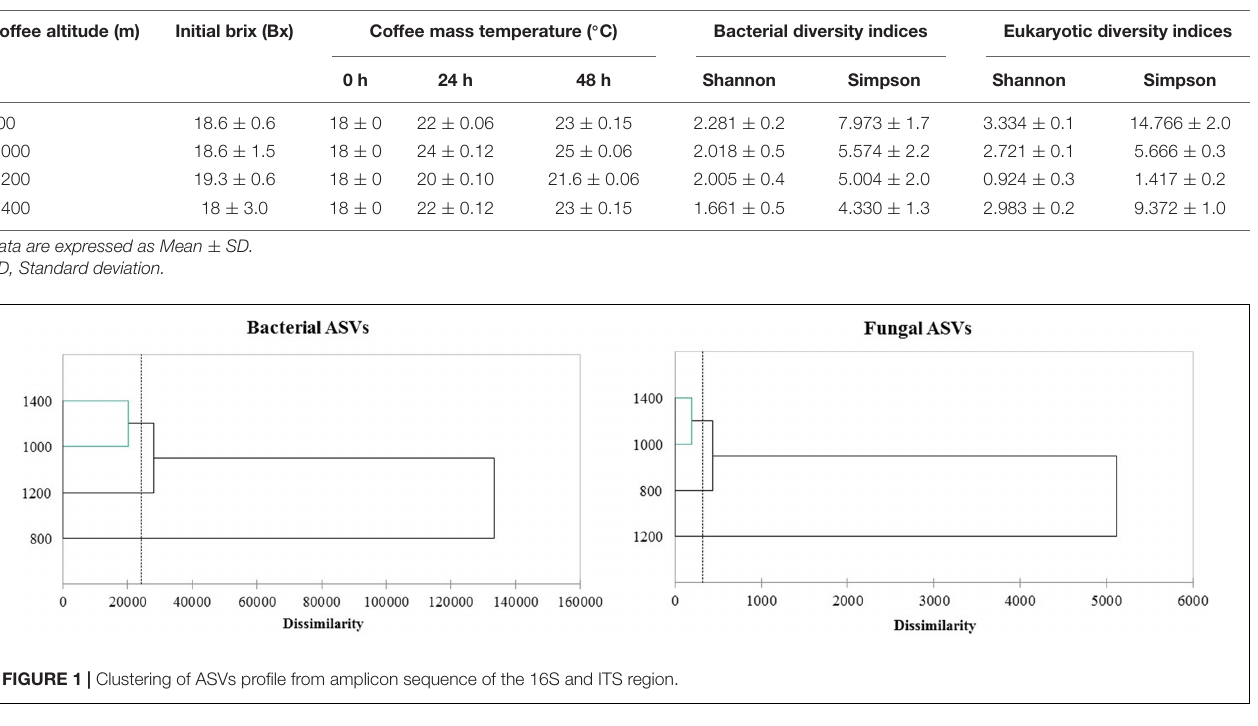
TABLE 1 | Fruits initial brix, coffee mass temperature, and microbial diversity indices.